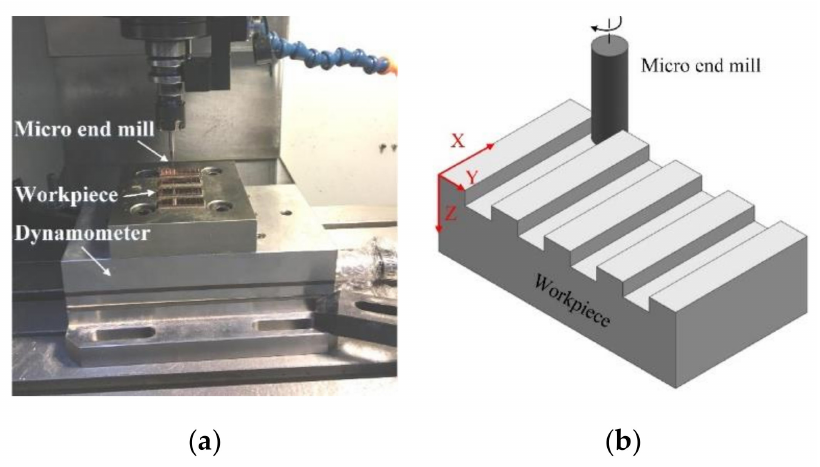
Figure 4. Micro milling experiment: ( a ) vertical machining center, ( b ) schematic of groove milling.